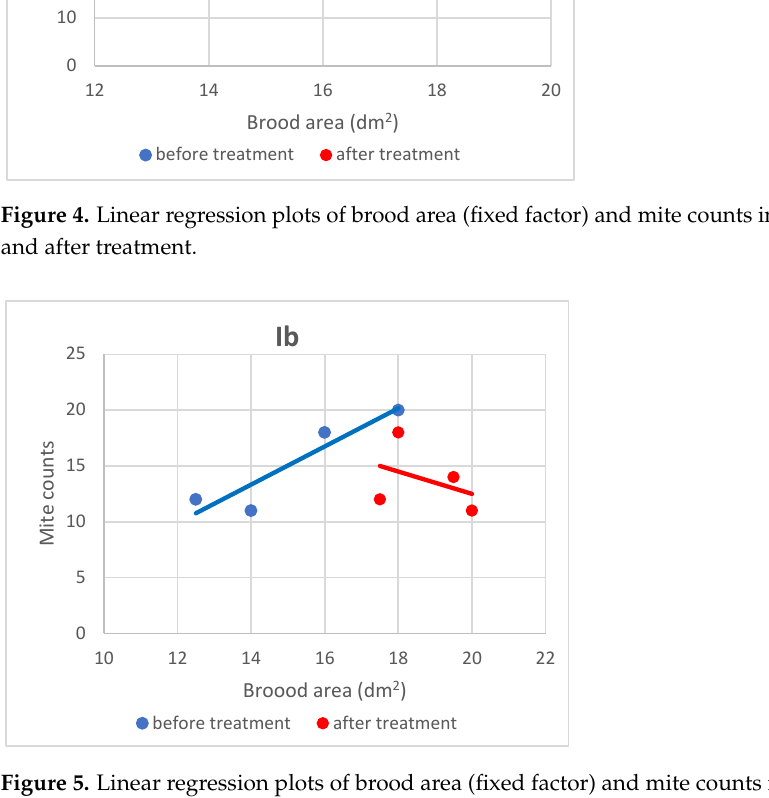
Figure 5. Linear regression plots of brood area (fixed factor) and mite counts in subgroup Ib before and after treatment.